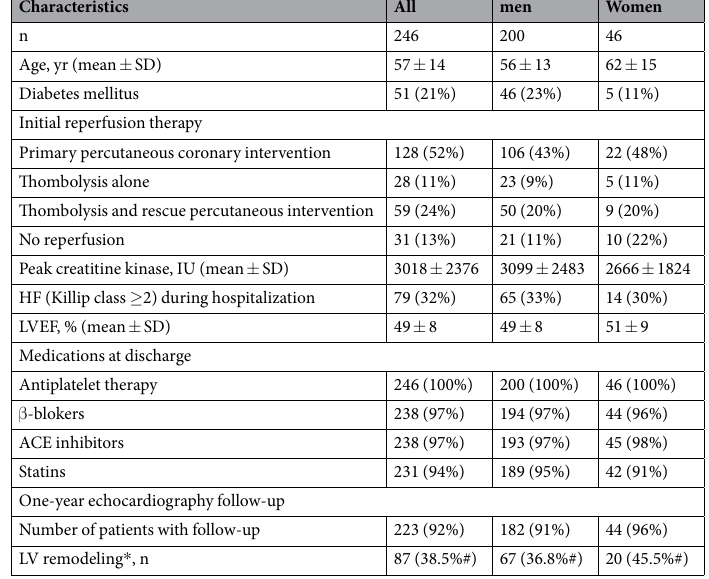
Table 1. Characteristics of the patients included in the REVE-2 study (n = 246). ACE indicates angiotensin- converting enzyme; HF, heart failure; IU, International units; LV, left ventricular; LVEDV, left ventricular end- diastolic volume; and LVEF, left ventricular ejection fraction. * Defined as a > 20% change in LVEDV between baseline and 12 months. #Of the patients with echocardiographic